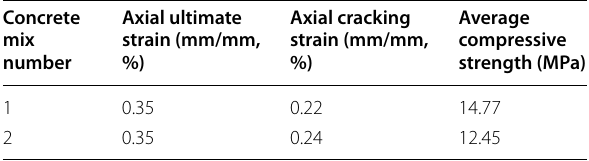
Table 2 Concrete characteristics.